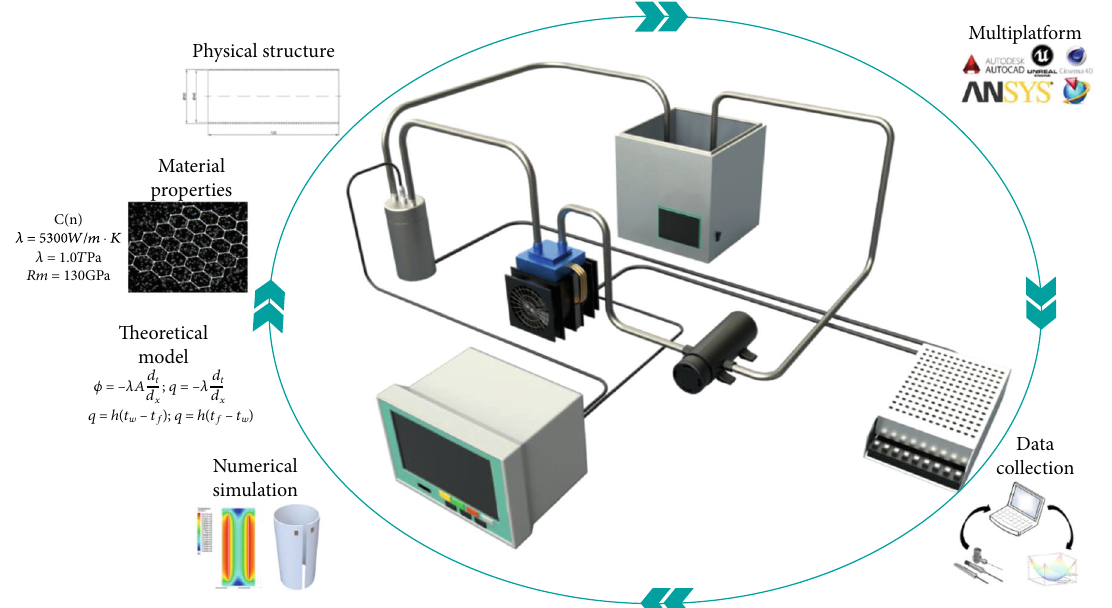
Figure 10: Corresponding digital twin